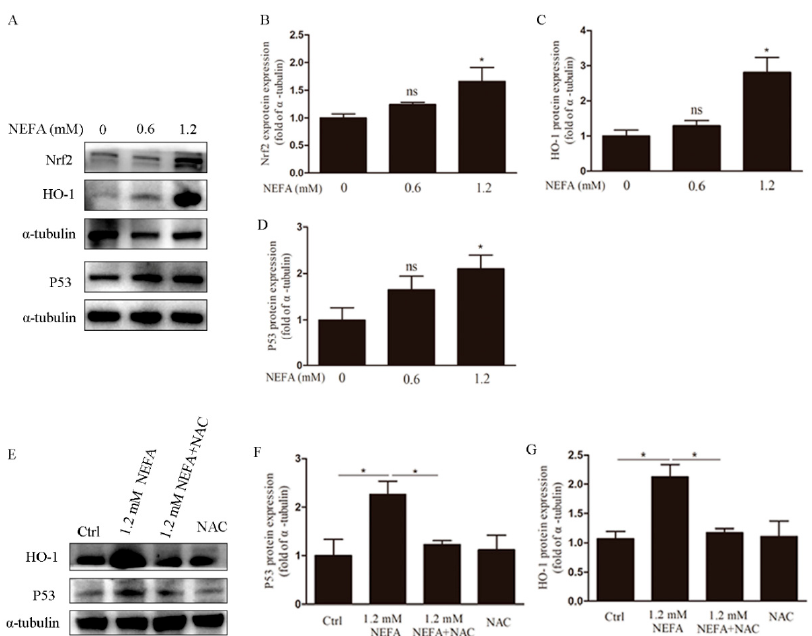
Figure 6. NEFA upregulated Nrf2, HO-1, and p53 protein expression. ( A – D ) After treatment with di ff erent concentrations of NEFA, protein expression of Nrf2, HO-1, and P53 were evaluated by western blotting. ( E – G ) After pre-treatment with NAC, expression of HO-1 and P53 genes were analyzed via western blot. These results indicated that the ROS induced by NEFA upregulated the expression of Nrf2, HO-1, and P53 proteins. Data are presented as mean ± SEM, * p < 0.05.